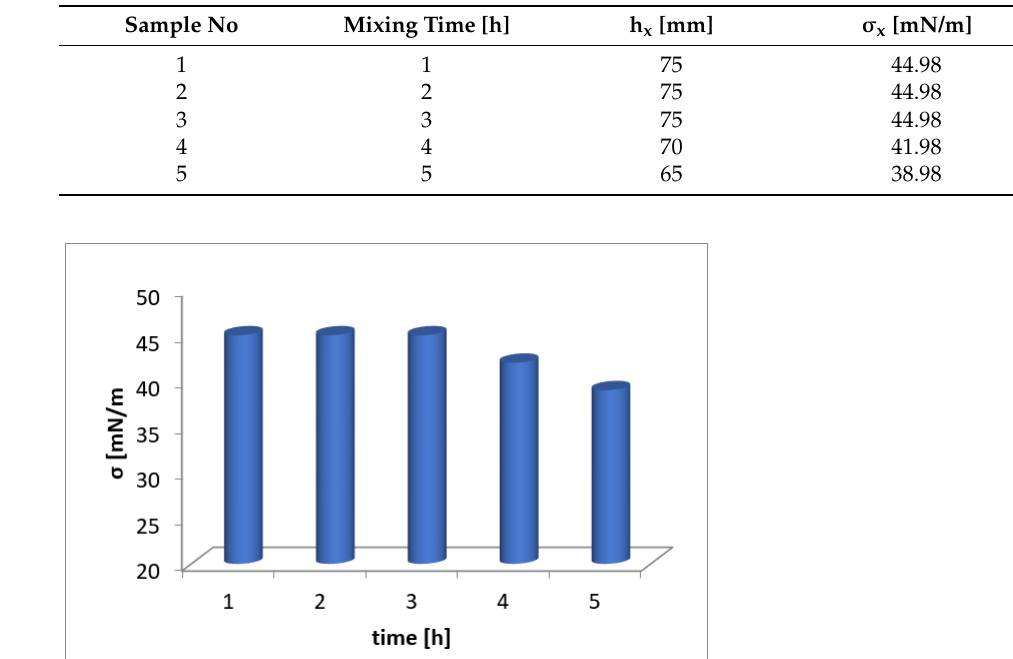
Table 6. Results of surface tension of extracts at different mixing times.